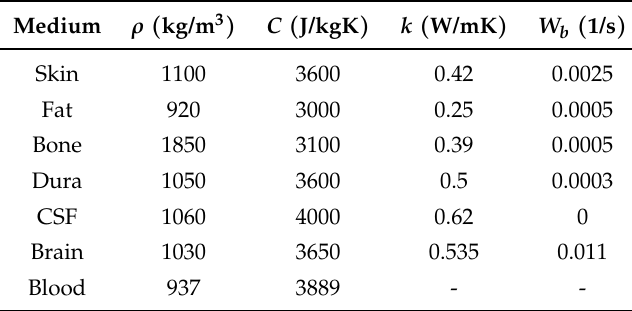
Figure 3. Reflectance and transmittance spectrum of the six-layered dielectric slab shown in Figure 1. Table 2. Bioheat parameters of the layered